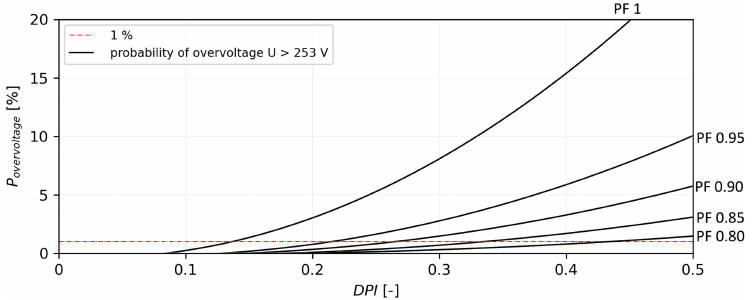
Figure 11. CDF calculated for overvoltage in the network for V1 scenario.